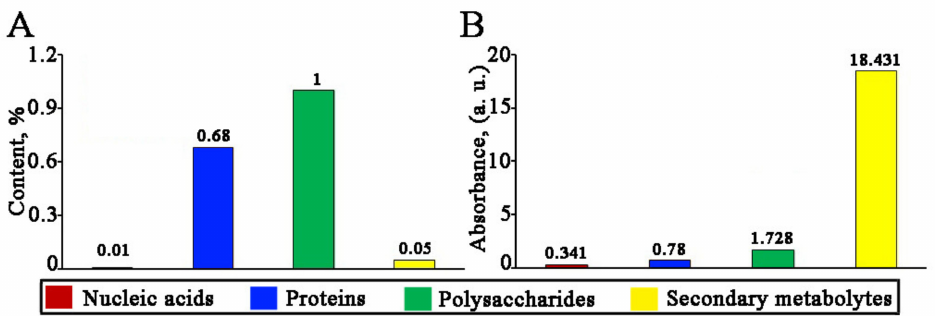
Figure 11. The relative content of nucleic acids, proteins, polysaccharides, and secondary metabolites in L . erythrorhizon callus extract ( A ) and their reducing activity with respect to silver ions ( B